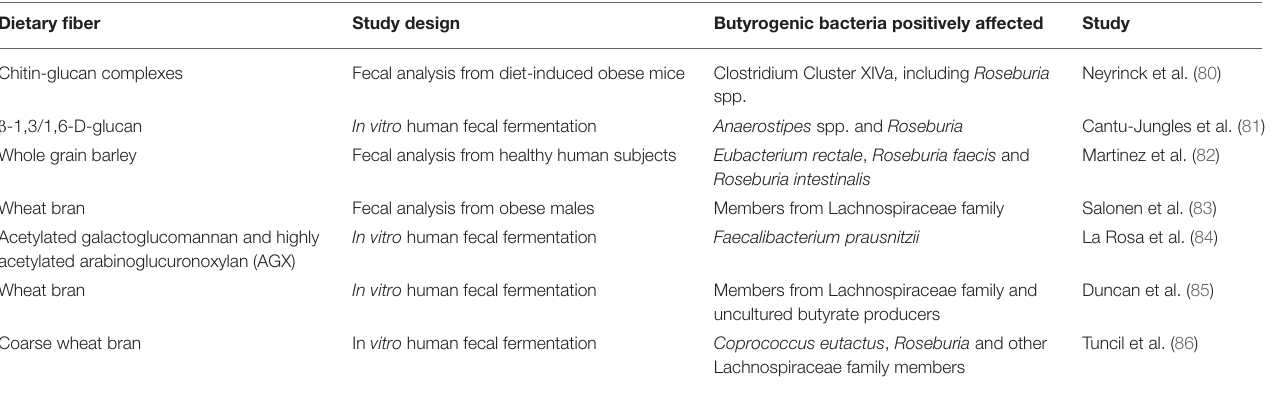
TABLE 1 | Examples of insoluble substrates capable of promoting butyrogenic colonic bacteria. Dietary